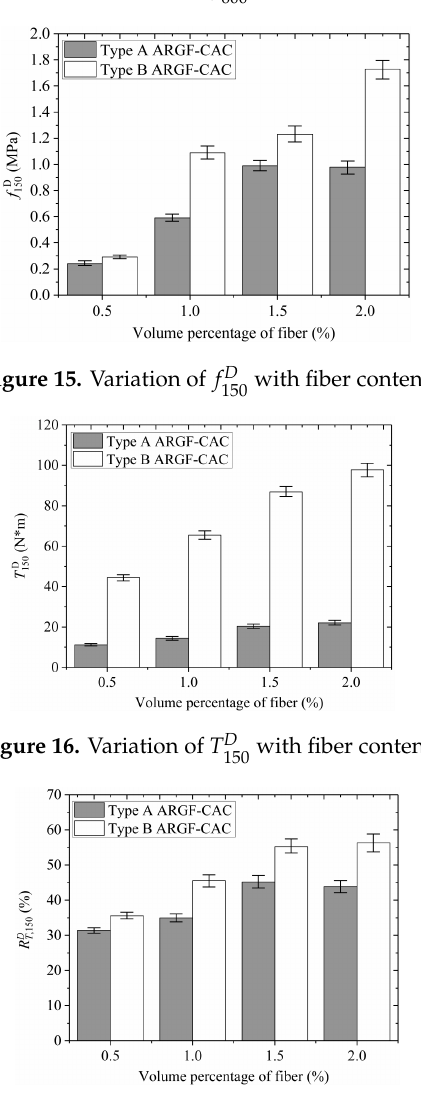
Figure 14. Variation of D f 600 with fiber content.